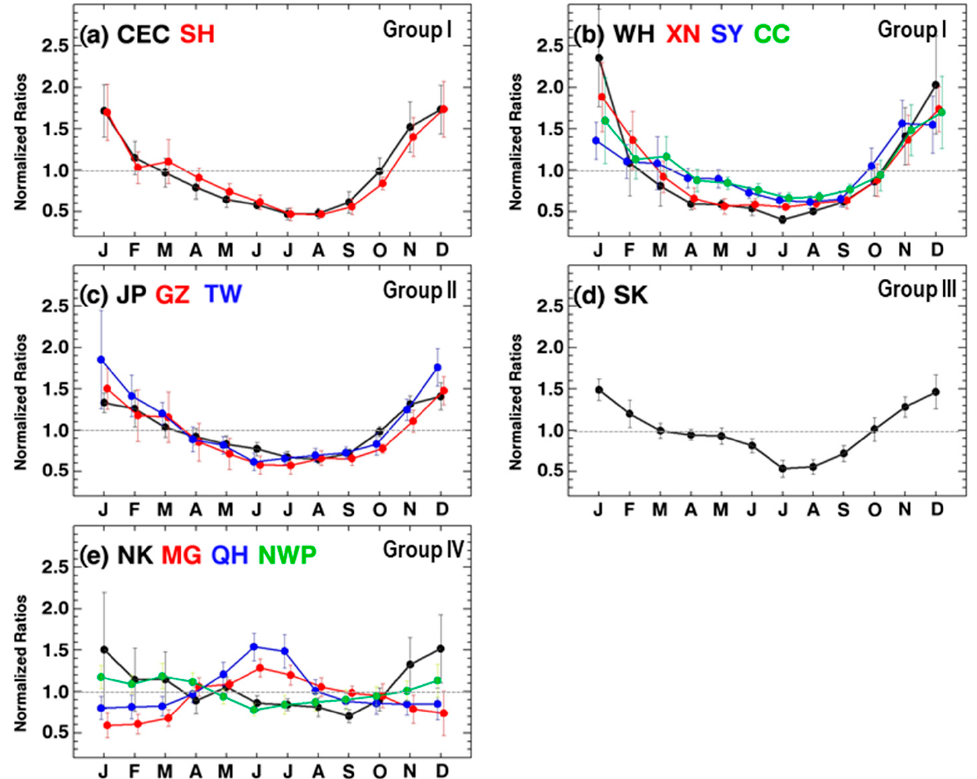
Figure 5. Monthly variations of Ω normalized to 10-year average for each ( a ) CEC and SH, ( b ) WH, XN, SY, and CC, ( c ) JP, GZ, and TW, ( d ) SK, and ( e ) NK, MG, QH, and NWP. Vertical bars represent 1- σ standard deviation.